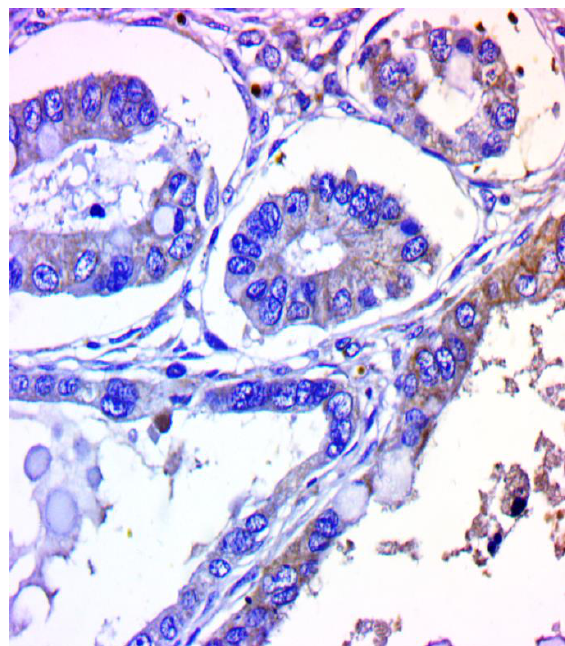
Figure 5: IHC of serous carcinoma with highly reduced (+), expression of type IV collagen, the linear staining of basement membrane underlie the neoplastic cells were less than 20% (arrow)